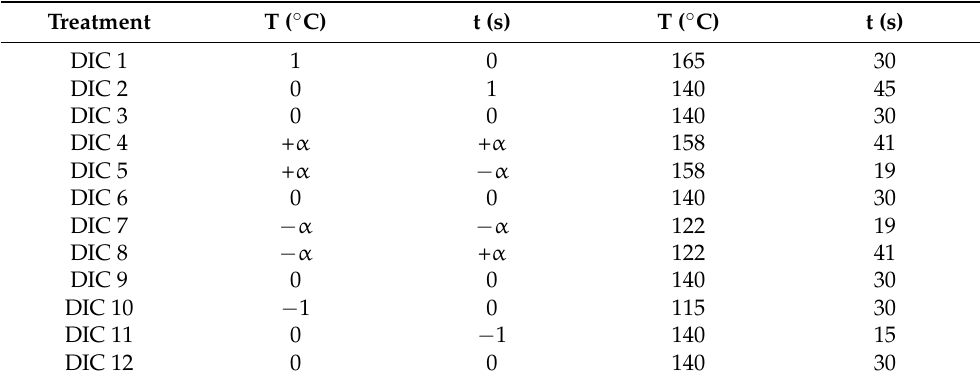
Table 2. Experimental design of the DIC pretreatment